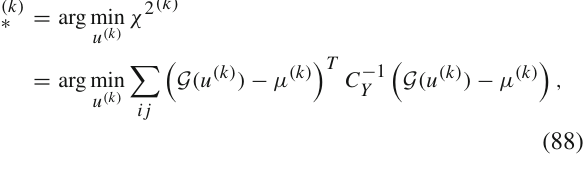
generated by augmenting y 0 with some noise, (cid:17) ( k )